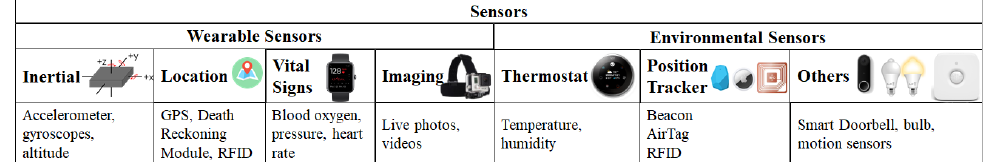
Table 2. Categories of sensors and devices used in pervasive healthcare Internet of Things, namely wearable sensors and environmental sensors.